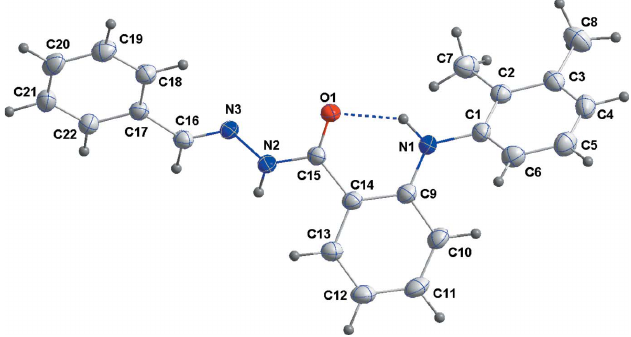
Figure 2 The molecule of (II) with atom-labeling scheme and displacement ellipsoids drawn at the 50% probability level. The intramolecular N— H (cid:2)(cid:2)(cid:2) O hydrogen bond is shown by a dashed line.